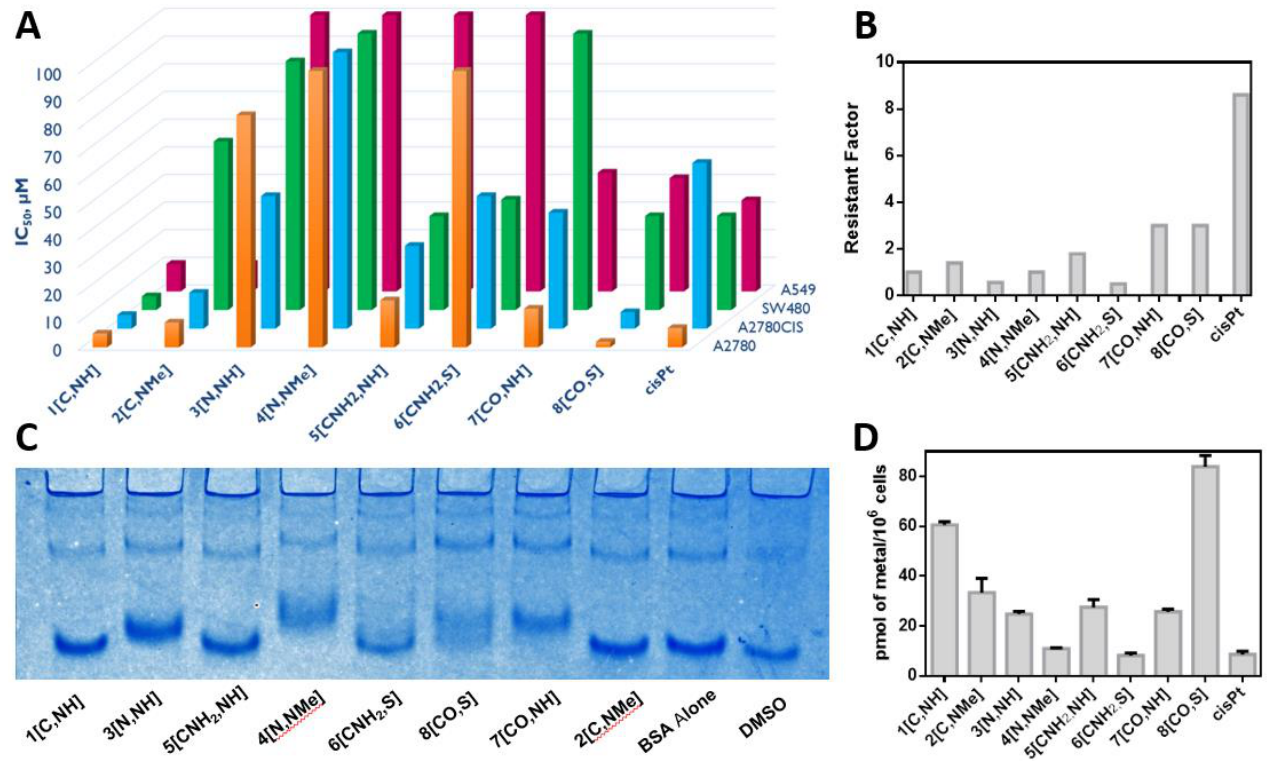
Figure 4. ( A ) Cytotoxic activity (IC 50 expressed in µM) of iridium complexes at 48 h as in ovarian A2780, A2780cis (ovarian acquired resistance to cisplatin), colon SW480 and lung A549 cancer cells. ( B ) Ratio of the IC 50 values of the studied complexes in A2780cis respecting those in A2780. ( C ) Native acrylamide gel electrophoresis of BSA in the presence of the iridium complexes, C D /C P =10. ( D ) Metal accumulation in SW480 cells treated during 24 h with 2 µM of the complexes. For original native PAGE gel image, see Figure